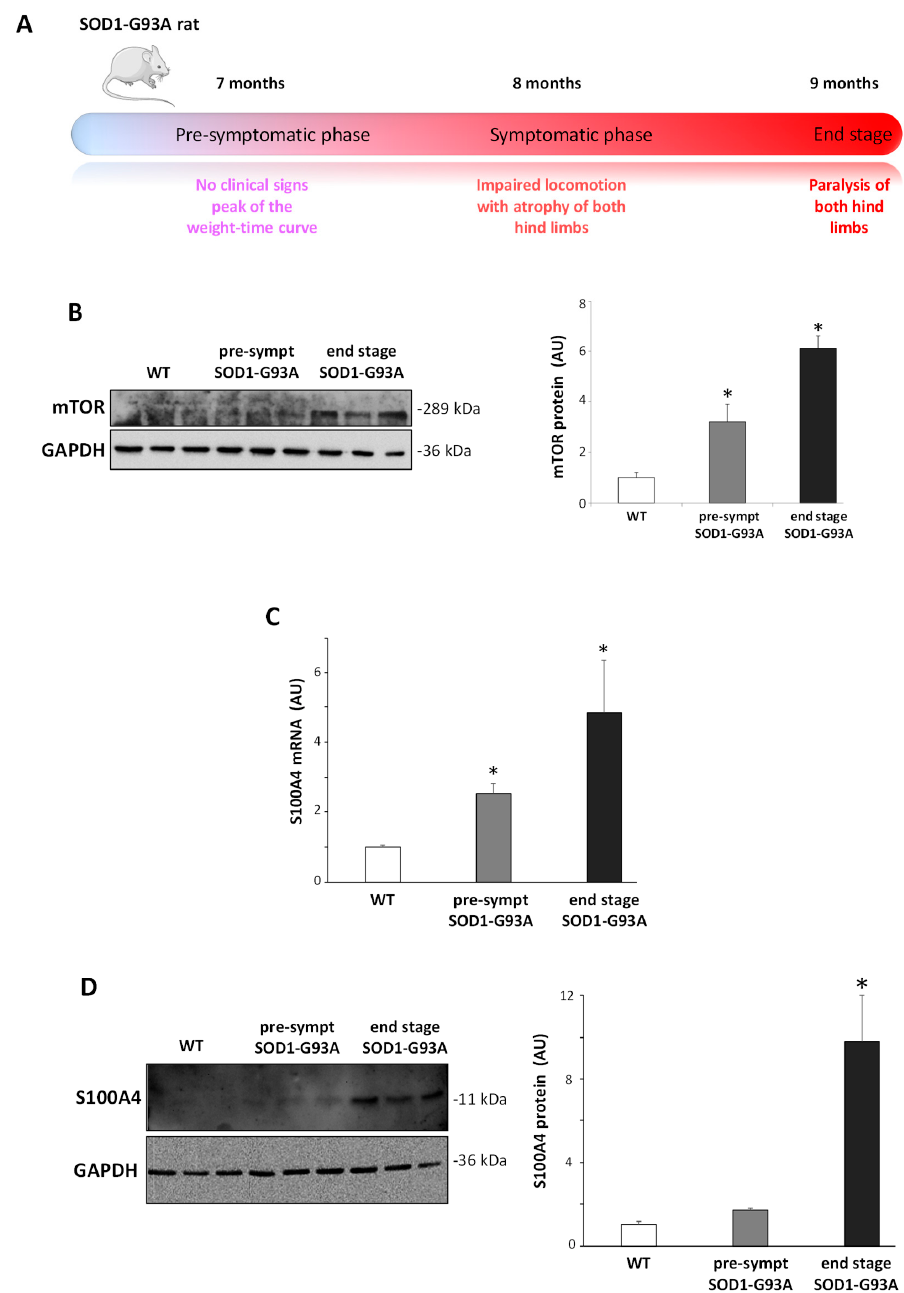
Figure 5. Increase in the S100A4 mRNA and protein in the lumbar spinal cord from pre-symptomatic and end-stage SOD1-G93A rats. ( A ) Schematic illustration of the disease development and progression in the SOD1-G93A transgenic rats. ( B ) Protein lysates of the lumbar spinal cord from wild-type (WT), pre-symptomatic, and end-stage SOD1-G93A rats were analyzed by western blot with the anti-mTOR antibody. ( C )mRNAfromthelumbarspinalcordfromWT,pre-symptomatic, andend-stageSOD1-G93A rats was analyzed by RT-qPCR, and quantification expressed in arbitrary units (AU), relative to WT animals. ( D ) Protein lysates of the lumbar spinal cord from WT, pre-symptomatic, and end-stage SOD1-G93A rats were analyzed by western blot with the anti-S100A4 antibody. Anti-GAPDH antibody was used to normalize the samples. The graph shows signal quantification expressed in arbitrary units (AU), relative to WT animals. Data are reported as mean ± S.E.M. (n = 3 animals per group). Statistical significance was calculated by ANOVA followed by Post Hoc Tukey’s test. * p < 0.05 relative to WT